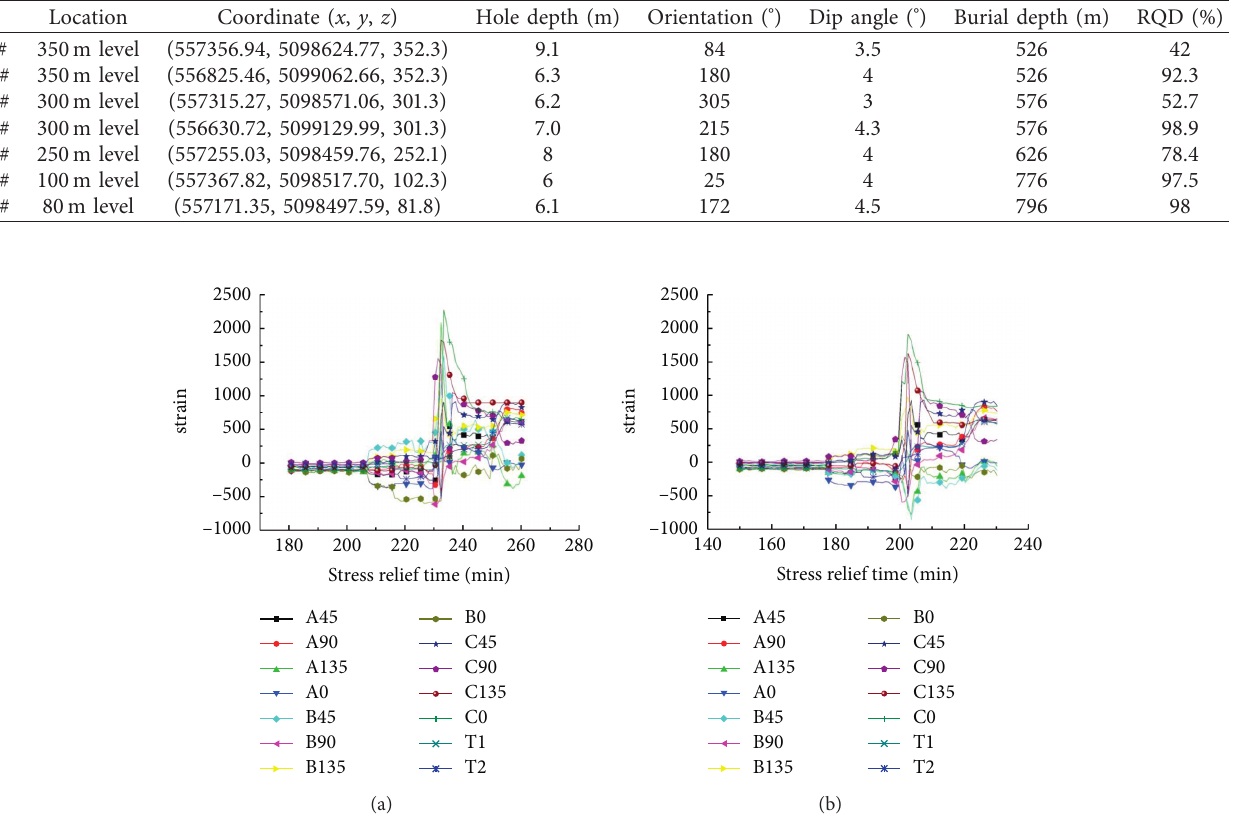
Table 1: Position of each measuring point of ground stress and parameters of test holes.